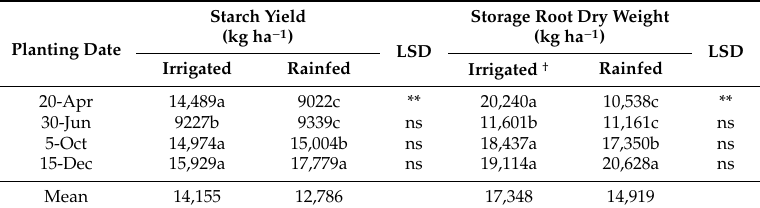
Table 3. Means for starch yield (kg ha − 1 ) and storage root dry weight (kg ha − 1 ) of cassava cv. Rayong 9 under irrigated and rainfed conditions at harvest (12 months after planting